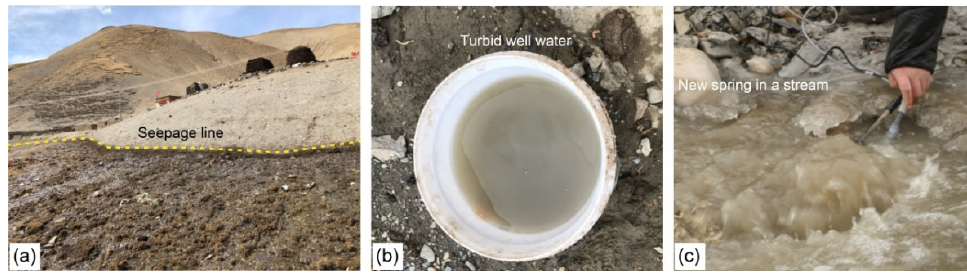
Figure 2. Groundwater responses to the Biru M6.1 earthquake. ( a ) New seepage line (c1), ( b ) water in the well (w6) that became turbid, and ( c ) a new spring (s1) after the earthquake.